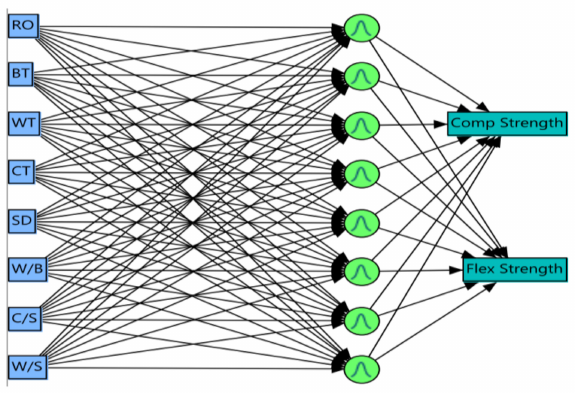
Figure 10. Artificial neural network structure for brick bond strength estimation. Table 8. Description of variables for brick bond strength